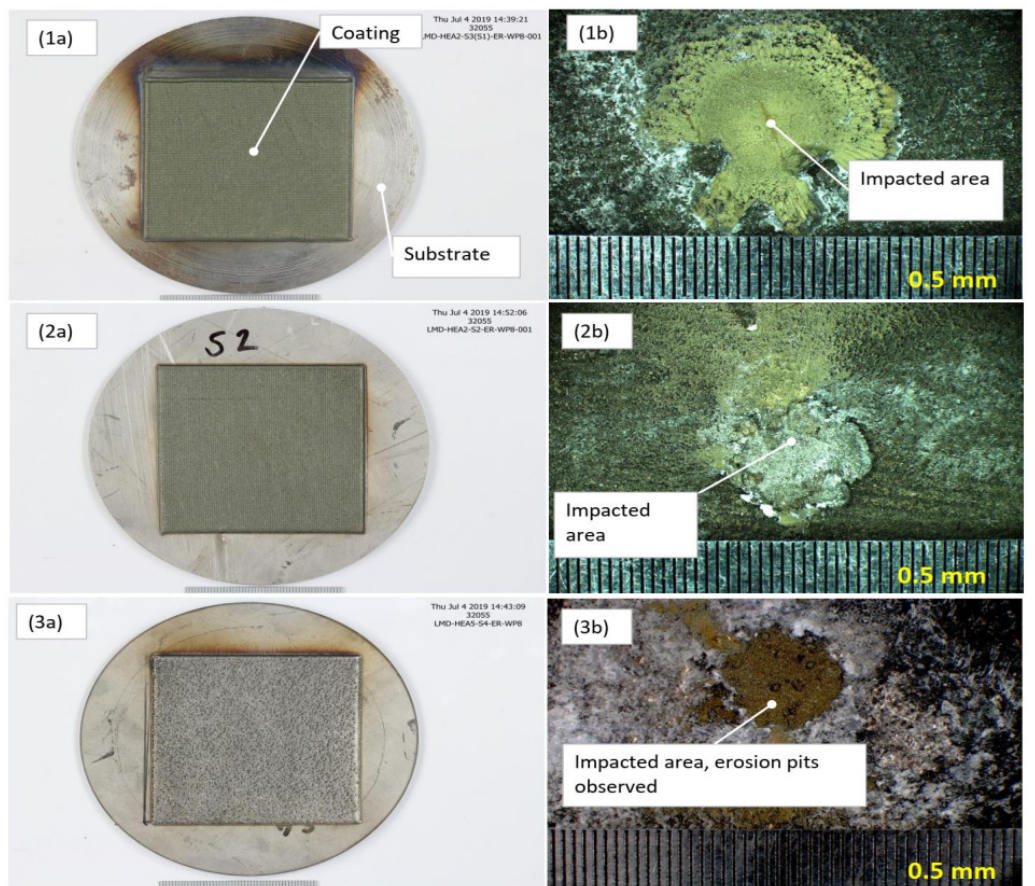
Figure 14. Erosion disc test samples. ( 1a ) Mo-HEA-S235JR test plate before exposure and ( 1b ) the impacted area after exposure. ( 2a ) Mo-HEA-316L test plate before exposure and ( 2b ) the impacted area after exposure. ( 3a ) Al-HEA-304L test plate before exposure and ( 3b ) the impacted area after exposure.